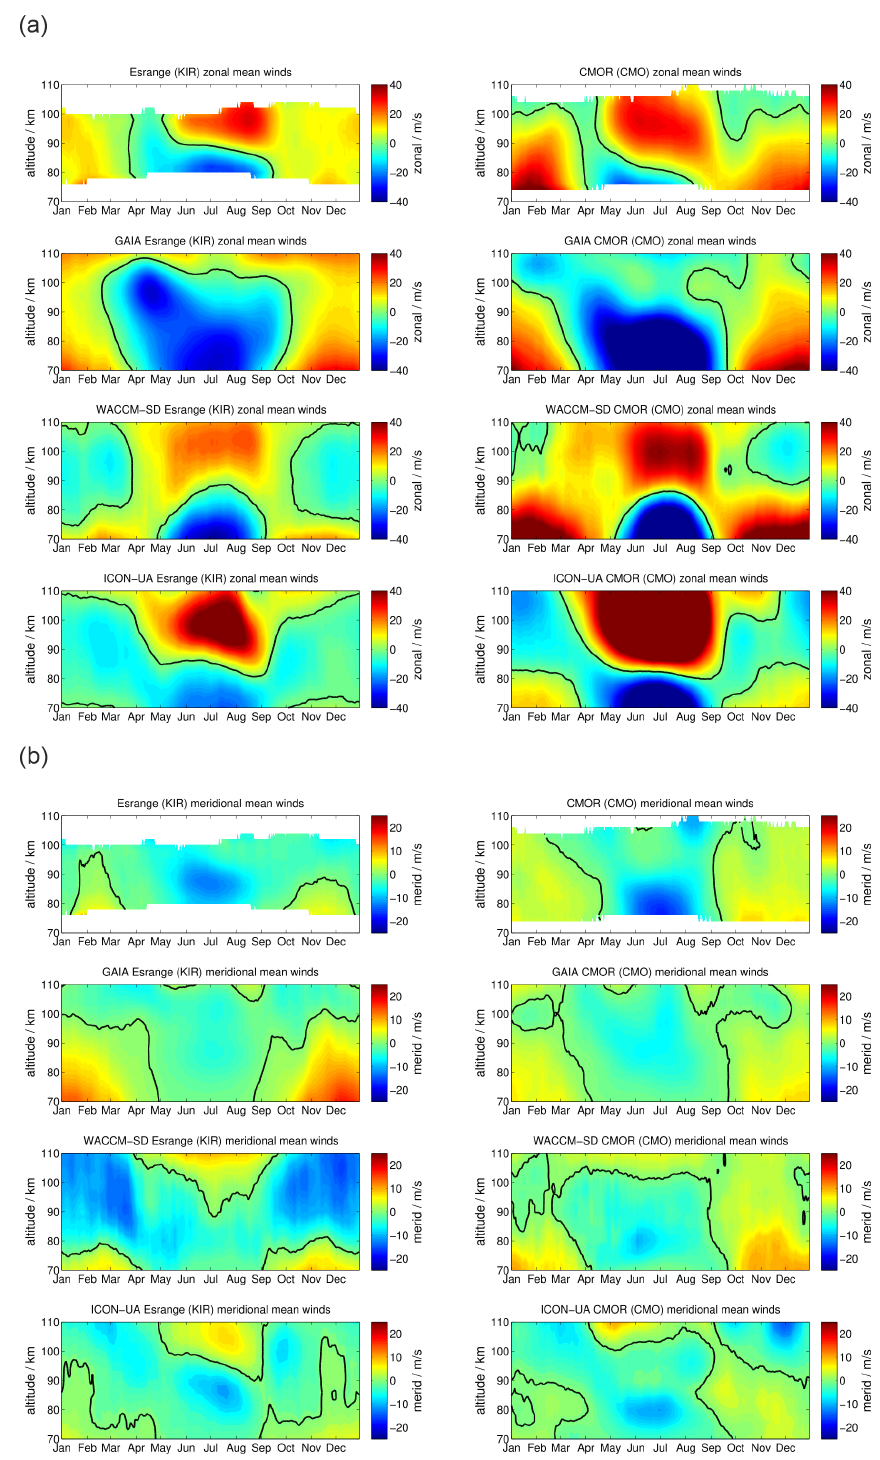
Figure A1. The same as Fig. 2, but for the midlatitudes at KIR and CMO.